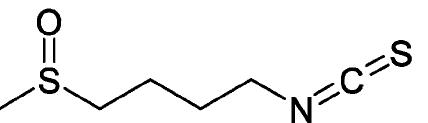
Figure 1. The molecular structure of 1 ‐ isothiocyanato ‐ 4 ‐ (methylsulfinyl)butane), also known as